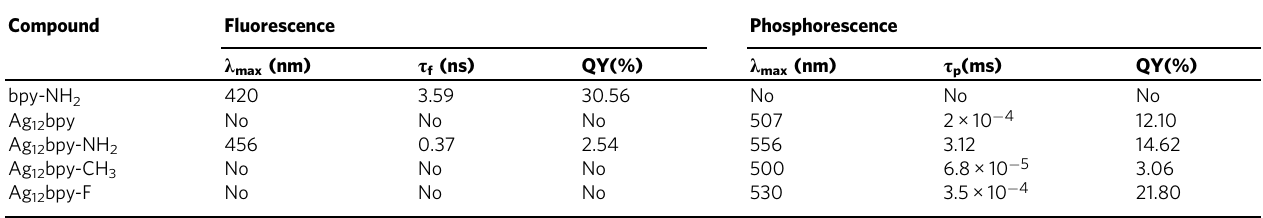
Table 1 Luminescent properties of the compounds.